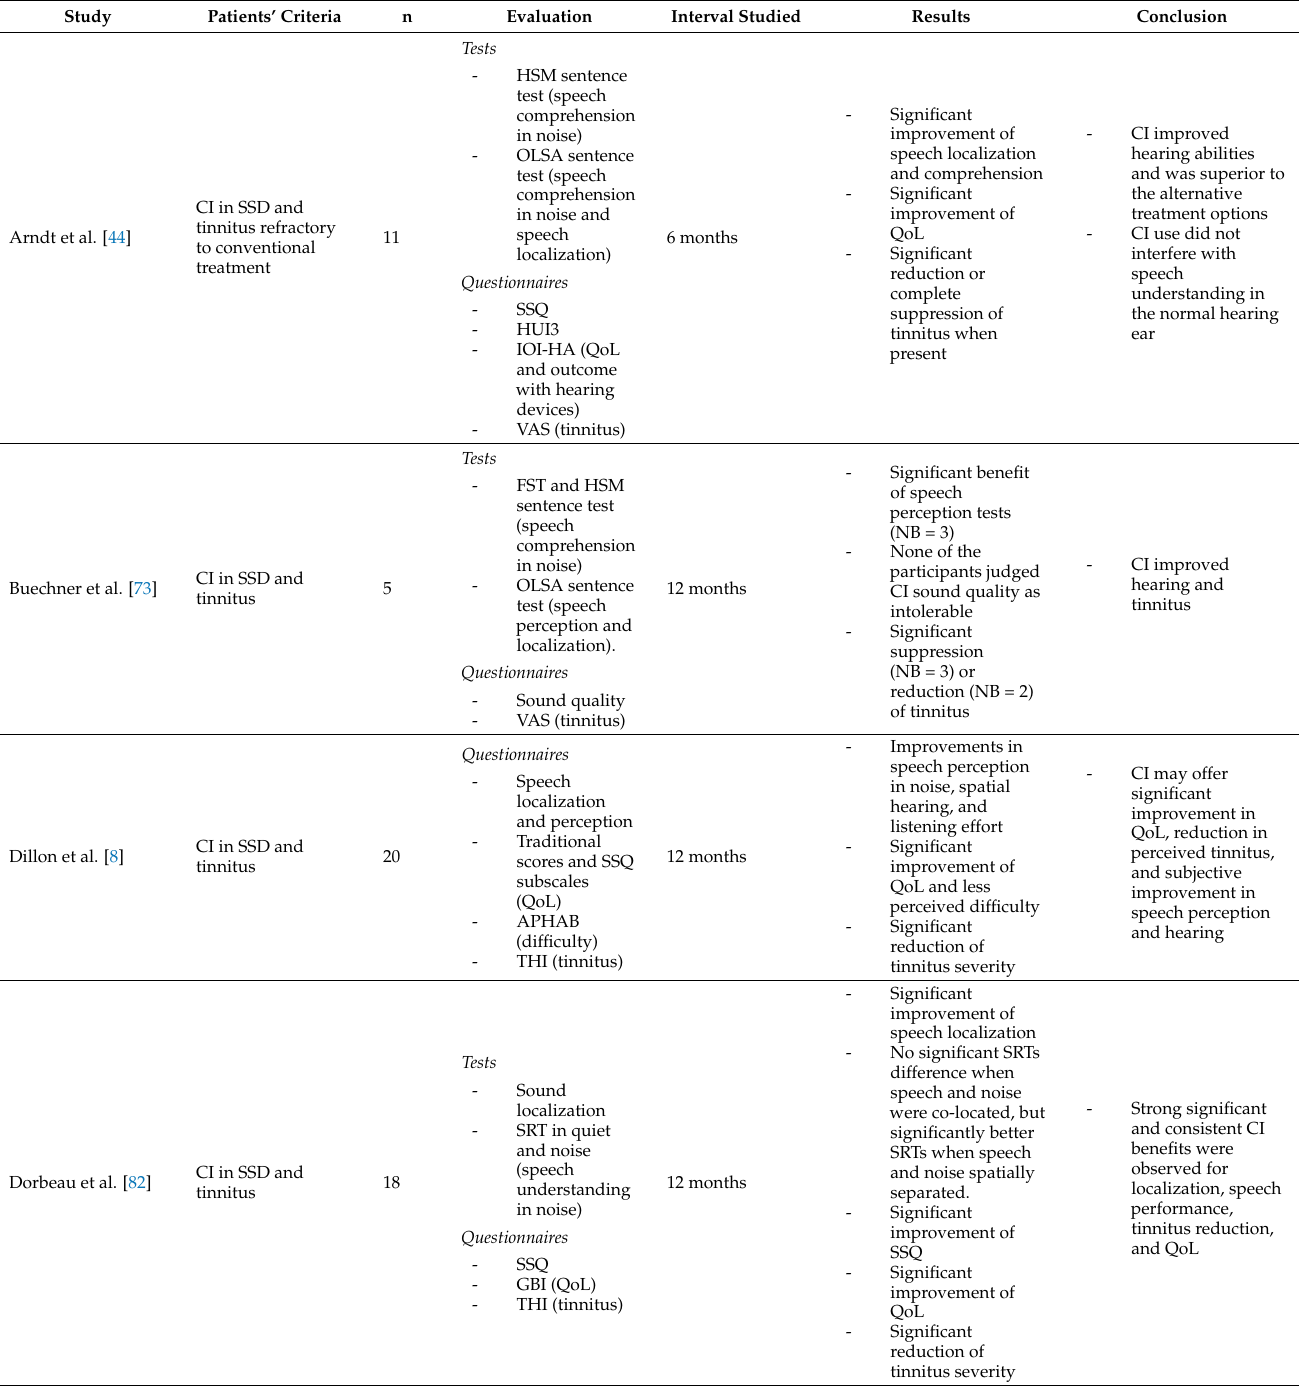
Table 4. Characteristics of studies investigating CI in SSD patients with disabling tinnitus in which tinnitus was not the primary